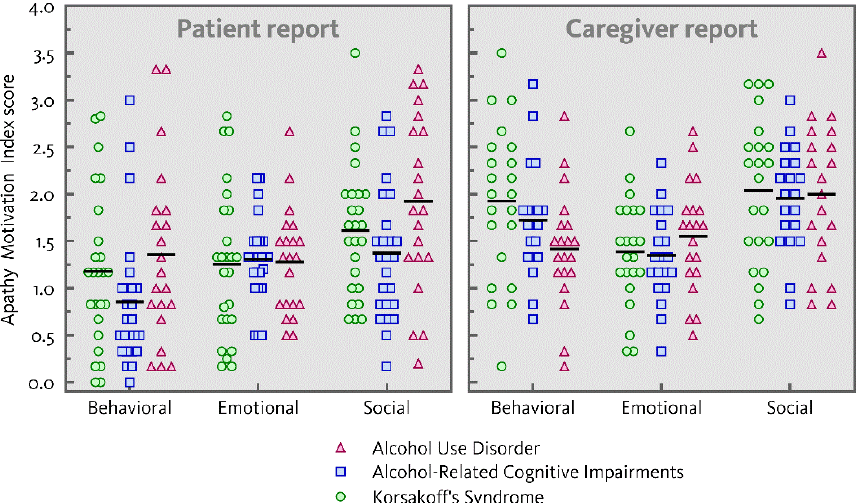
Figure 1. Individual mean ratings of behavioral, emotional and social apathy on the apathy mo- tivation index in patients with alcohol use disorder, alcohol-related cognitive impairments and Korsakoff’s syndrome as reported by patients and caregivers.